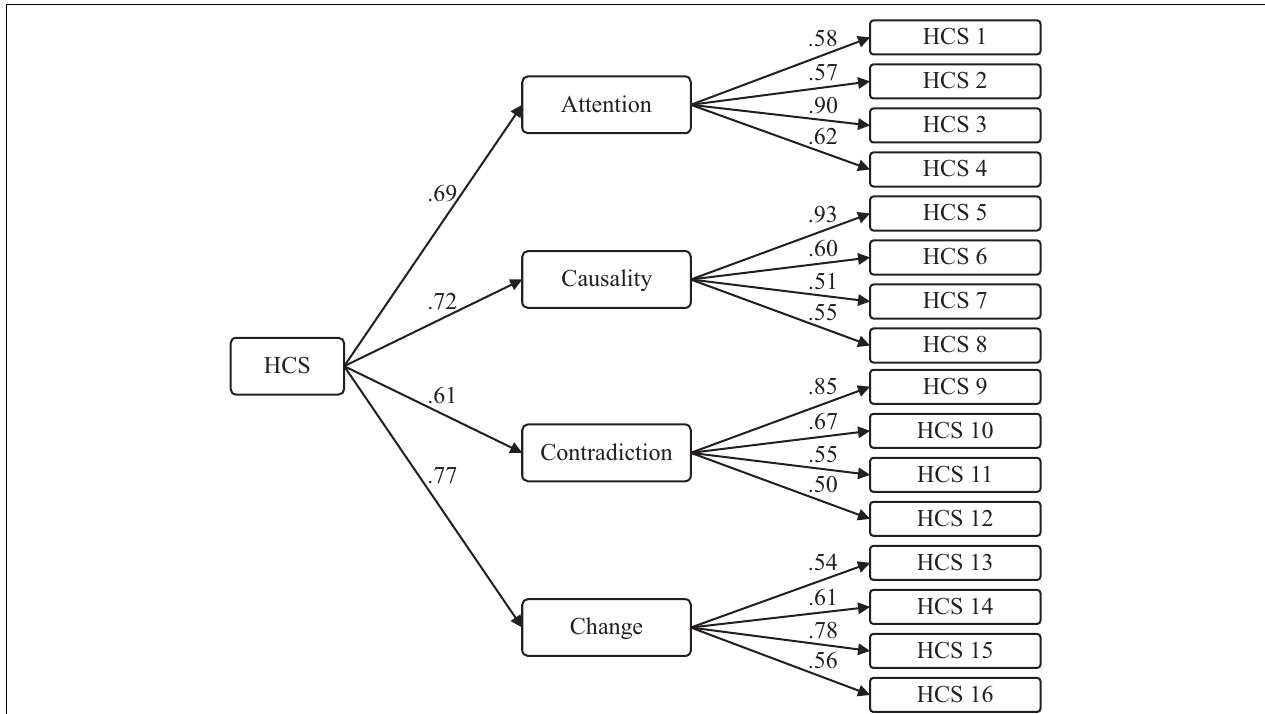
FIGURE 1 | Study 3 – confirmatory factor analysis of the 16-item HCS. Sample 2, N =